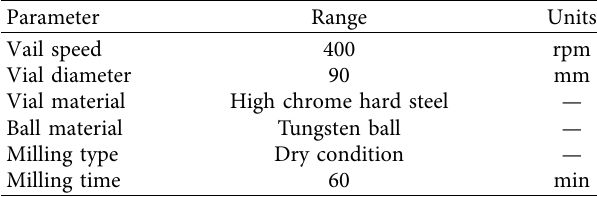
Table 1: Process conditions for ball